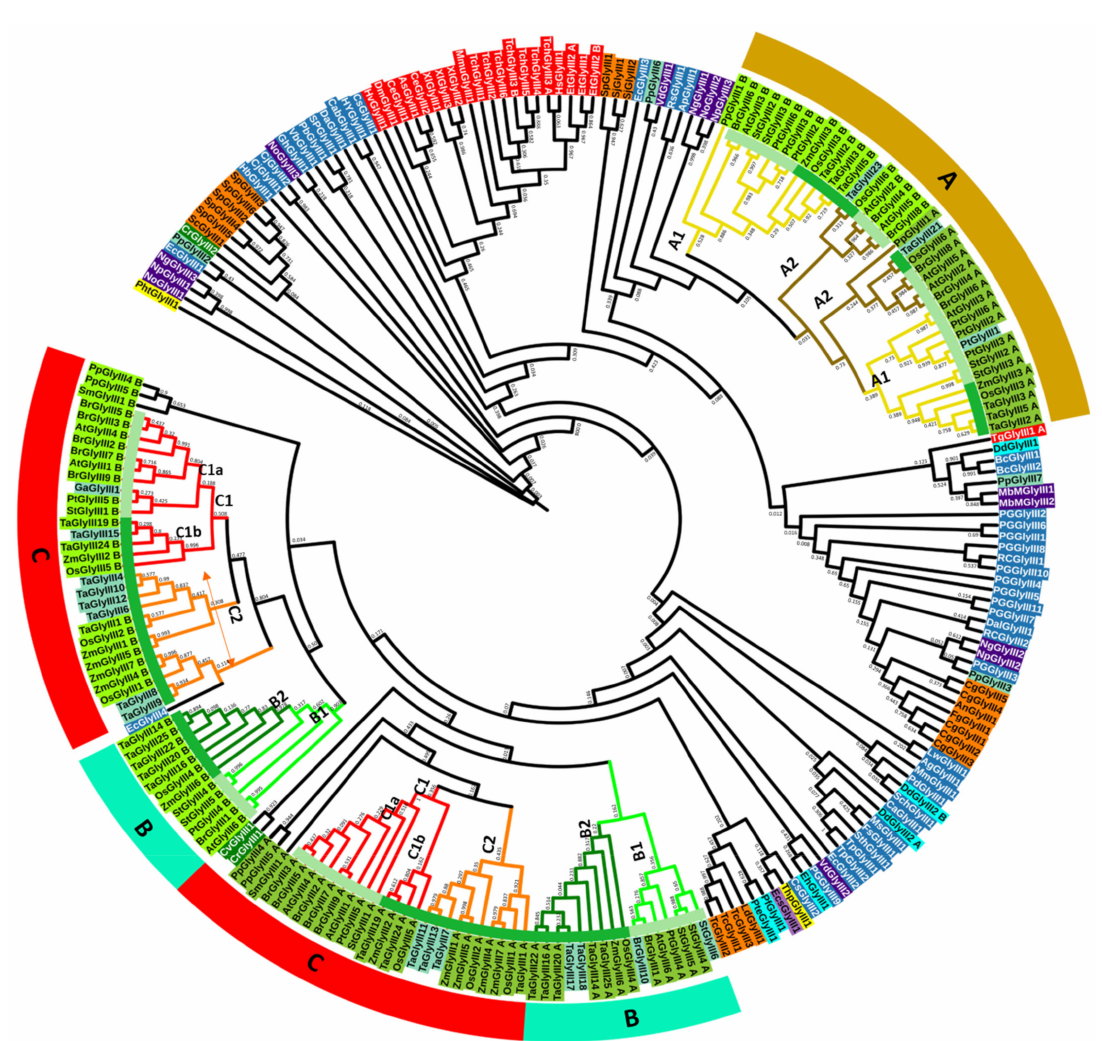
Figure 4. Domain relationship between GLYIII proteins unravel differential evolution of two DJ-1_PfpI domains in plants. The maximum likelihood tree was constructed with 1000 bootstrap replicates (indicated over branches) in MEGA 7.0 using 238 sequences from 183 GLYIII proteins belonging to 69 species. Different sub-clusters (A1&2, B1&2, C1&2) are indicated in the tree and nodes are colored differently to enable ease in understanding. The two domains of plant GLYIII proteins group separately in each cluster and can be identified from the suffix A (for first or N-terminal domain) and B (for second or C-terminal domain). Outermost strip indicates the three types of plant GLYIII proteins represented as cluster-A (mustard strip), B (pale-green strip), and C (red strip). Innermost strip indicates monocot (dark green) and dicot (pale green) species. GLYIII proteins belonging to the different phylogenetic domains of life are depicted using specific colors as, archaea (purple), bacteria (blue), protists (cyan), fungi (orange), diatoms (yellow), brown algae (dark orchid), green algae (dark green), and plants (A-domain: light green, B-domain: dark olive green, plants with single domain: aquamarine) and animals